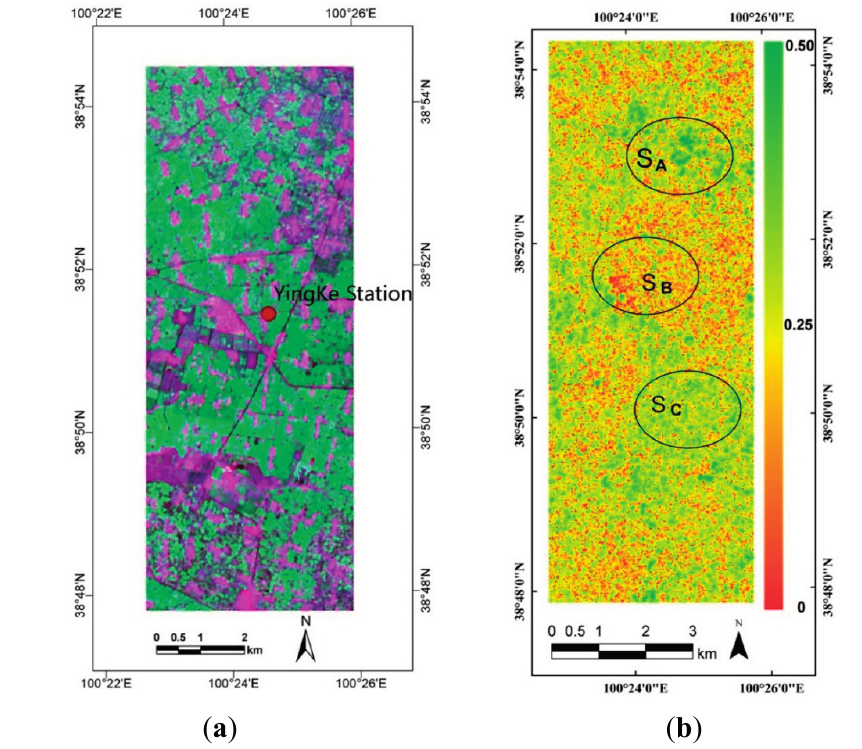
Figure 5. Hyperion image in RGB color ( a ) and retrieval image of soil moisture (cm 3 ·cm − 3 ) in study area ( b ).